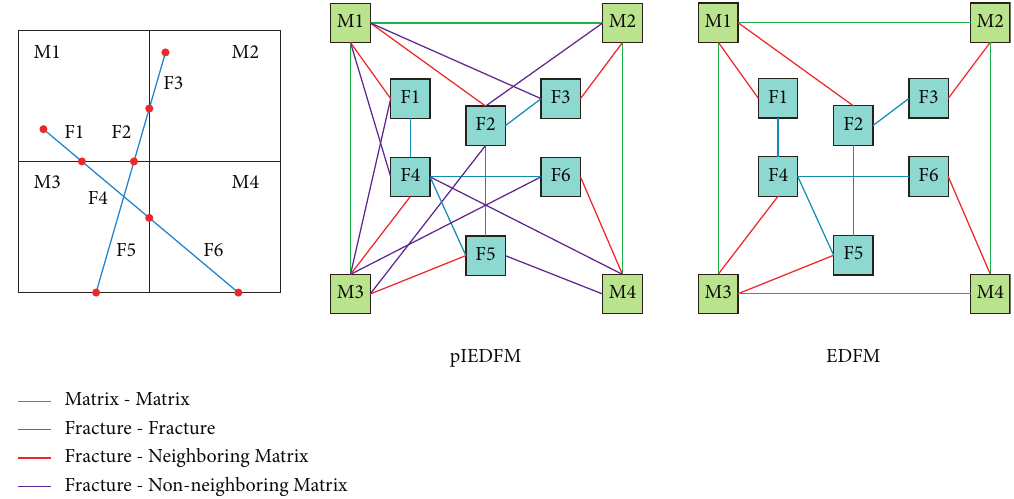
Figure 4: Schematic for connections in the pIEDFM and the EDFM.